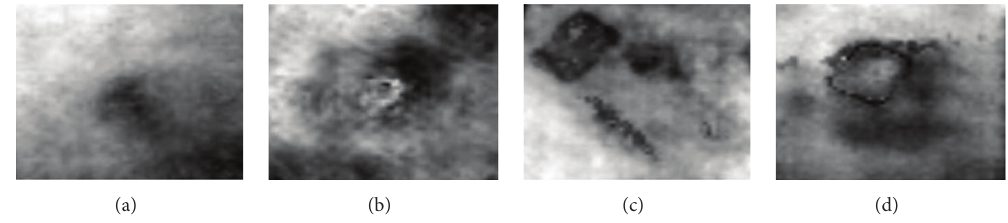
Figure 17: Results of the ICA-DWT data fusion algorithm obtained for sample: (a) 𝑠 IMP 2 J , (b) 𝑠 IMP 5 J , (c) 𝑠 INC A , and (d) 𝑠 INC B .